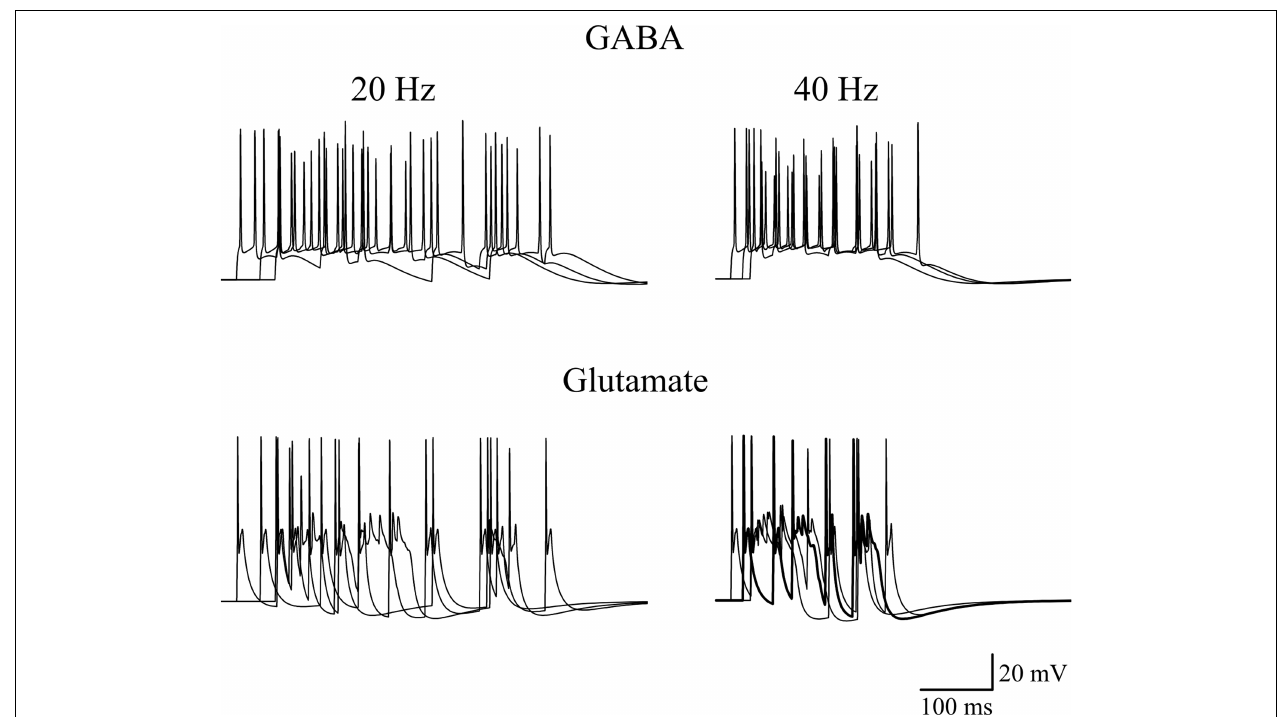
FIGURE 7 | Effects of GABAergic or glutamatergic synapses on a model neuron. Typical traces of somatic membrane potential are plotted during three simulations activating 30 synaptic inputs at an average frequency of 20 Hz ( left ) or 40 Hz ( right ), using GABAergic ( top ) or glutamatergic ( bottom ) synapses. The same stimulation pattern was used in both cases. The passive and active properties of the neuron were those used in a previous work, in a confi guration